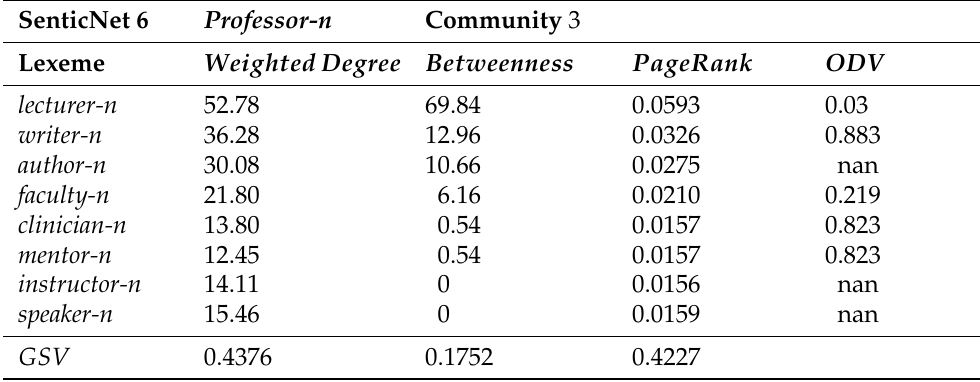
Table 5. GSV of community 3 of lexical dependency graph of lexeme professor-n calculated with SenticNet 6 polarity_value on ententen13